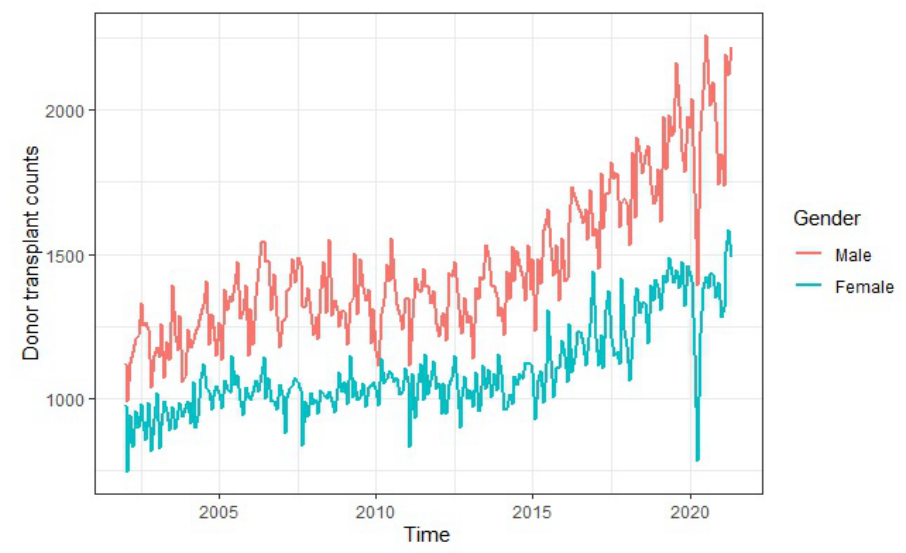
Figure 15. Donor transplant counts in the US across gender, based on OPTN data as of November 2021.